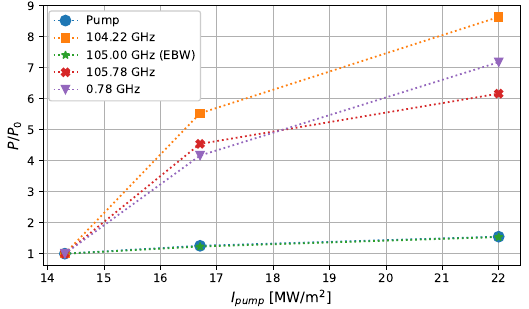
Figure 3: Normalized integrated spectral density (see fig- ure 2) for modes indicated in the legend, plotted against pump wave intensity. The fraction P / P 0 means that the values are normalized to that of the lowest intensity simu- lation. Di ff erent series are not comparable in